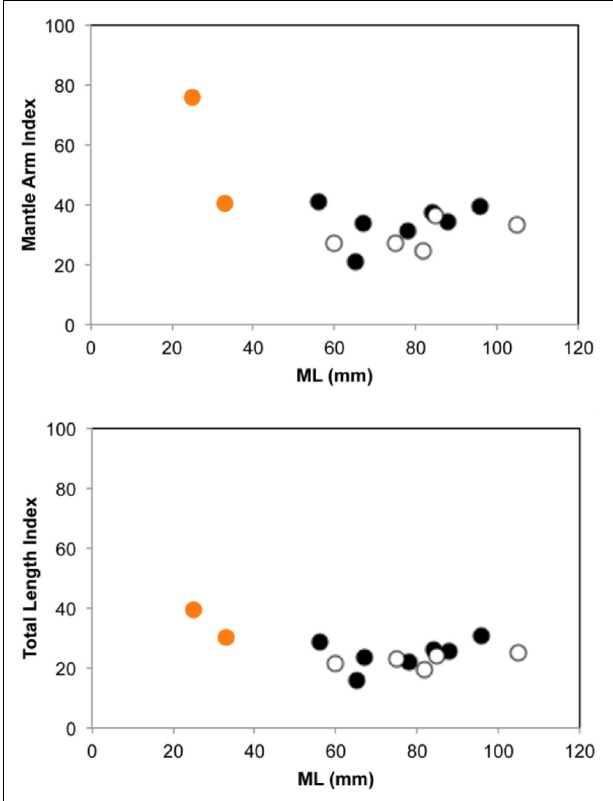
FIGURE 2 | Mantle arm index (up) and Total length index (down) in 14 individuals of Pteroctopus tetracirrhus measured after fixation. Black circles, males; white circles, females; orange circles, juvenile and sub-adult individuals of 25 and 33 mm ML, respectively, collected during present